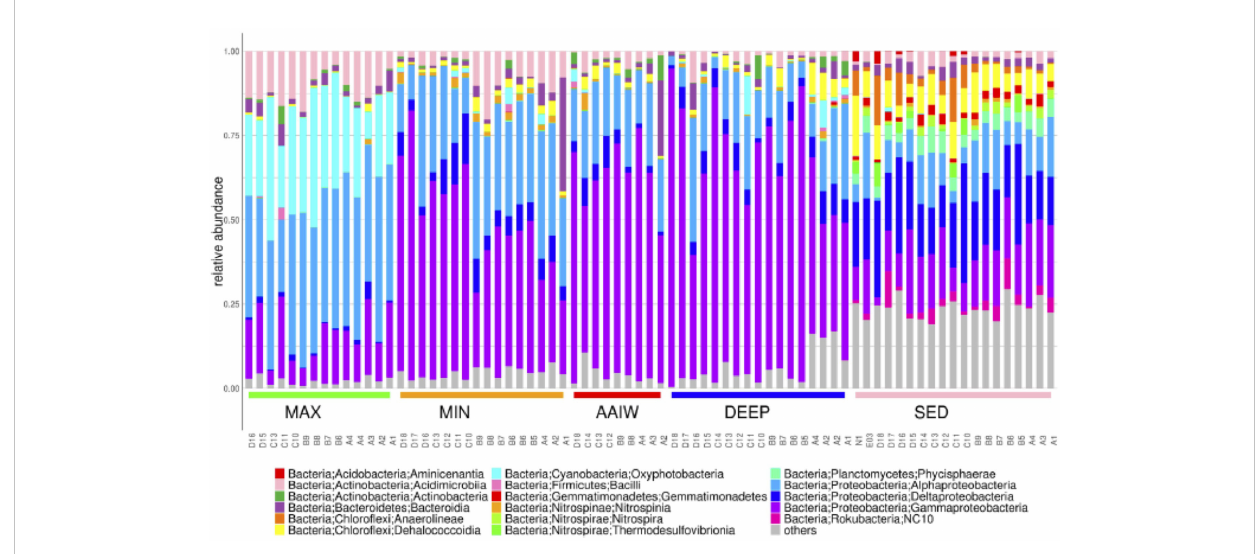
FIGURE 3 Bar plot of the relative abundances of the 16S rRNA amplicon taxonomic annotations at the Class level. Depth levels of collected samples in the water column in the central western margin (Perdido Region) and the southern GoM, maximum fl urescence depth (MAX), relative oxygen minimum (MIN), Antarctic Intermediate Water mass (AAIW), waters below 1500 m depth (DEEP), sediment samples (SEDIMENT). Notice diversity changes with depth through the water column and in the